Question: Draft a figure caption describing what is shown.
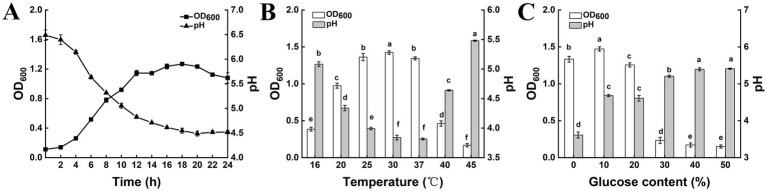
Answer: Growth and acid-producing characteristics of strain GXUN74722 under different culture conditions. (A) Growth curve and acid-producing performance of strain GXUN74722; (B) Effect of temperature on the growth and acid-producing of strain GXUN74722; (C) Effect of glucose content in MRS broth on the growth and acid-producing of strain GXUN74722.